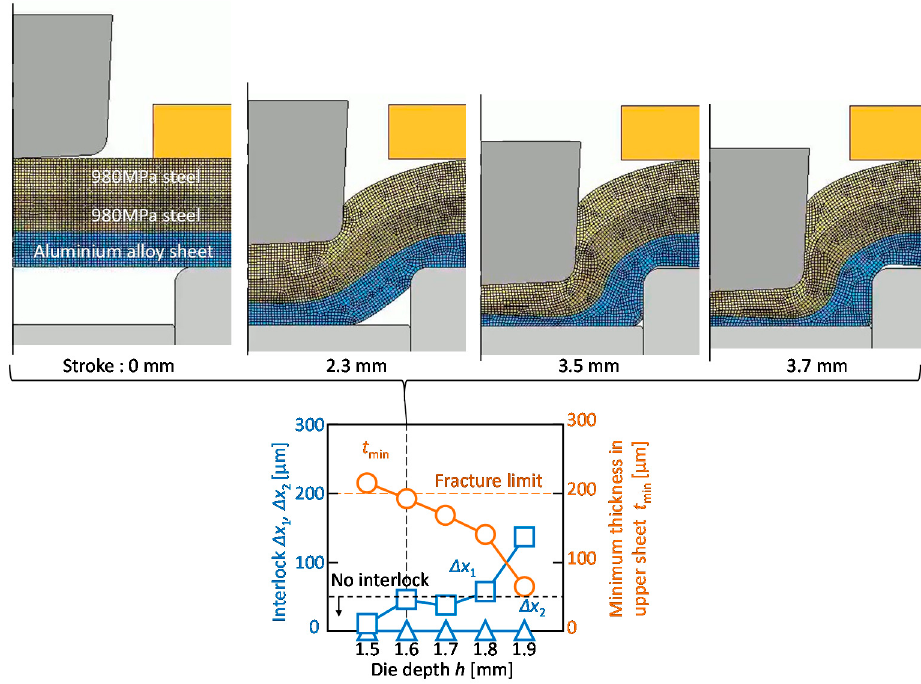
Figure 23. Effect of die depth on calculated interlocks and minimum thickness in upper sheet for d = 9 mm and 980 MPa steel sheets.